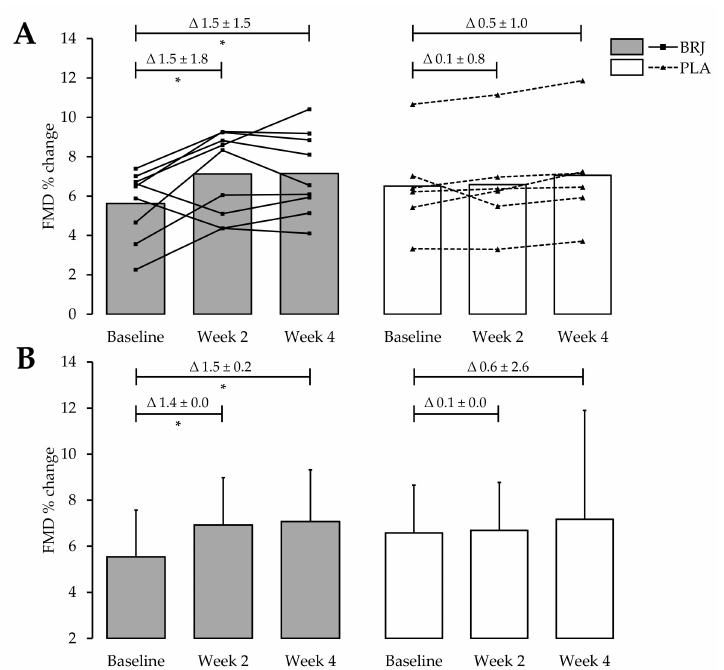
Figure 5. The e ff ects of four weeks of BRJ consumption or PLA on FMD. Beetroot juice consumption increases FMD responses in healthy older adults. Both ( A ) uncorrected and ( B ) allometrically scaled data are expressed as mean ± SD and individual data for uncorrected data. * Significance shown for comparisons within treatment allocations of the change between baseline, week 2 and week 4, p < 0.05 for the Bonferroni post hoc test. BRJ = beetroot juice; FMD = flow-mediated dilatation and PLA =